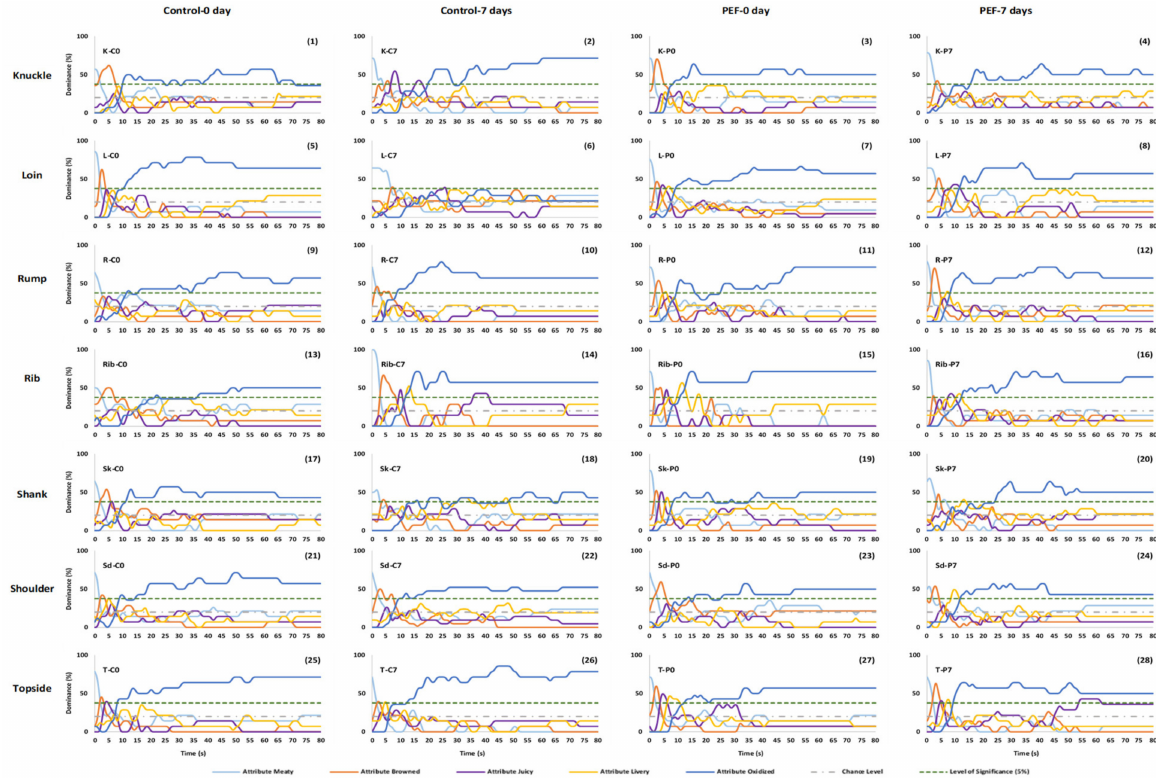
Figure 1. TDS curves of non-PEF and PEF treated cooked chilled lamb meat cuts (C: control; P: PEF; 0 and 7: number of storage